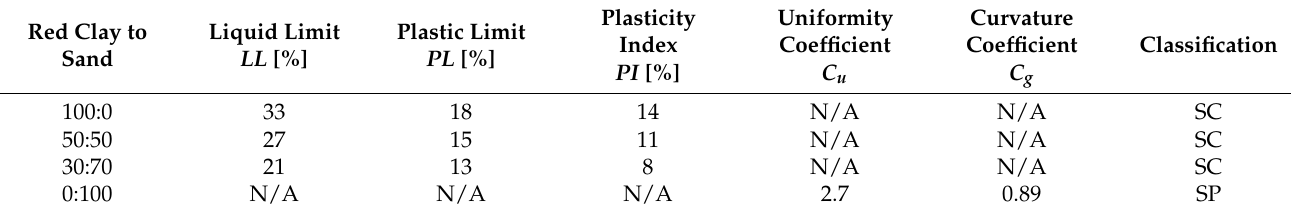
Red Clay to Sand